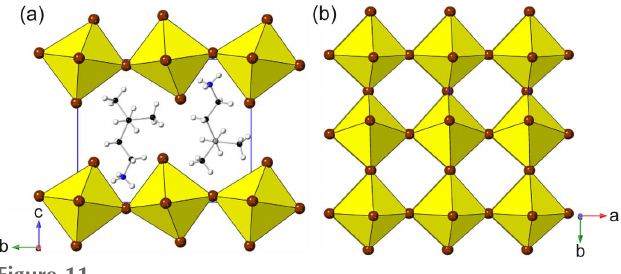
Figure 11 [C 5 H 16 PN]PbBr 4 (1883687) showing ( a ) tilting around a and ( b ) the view down the c axis corresponding to the a + b 0 c 0 tilt